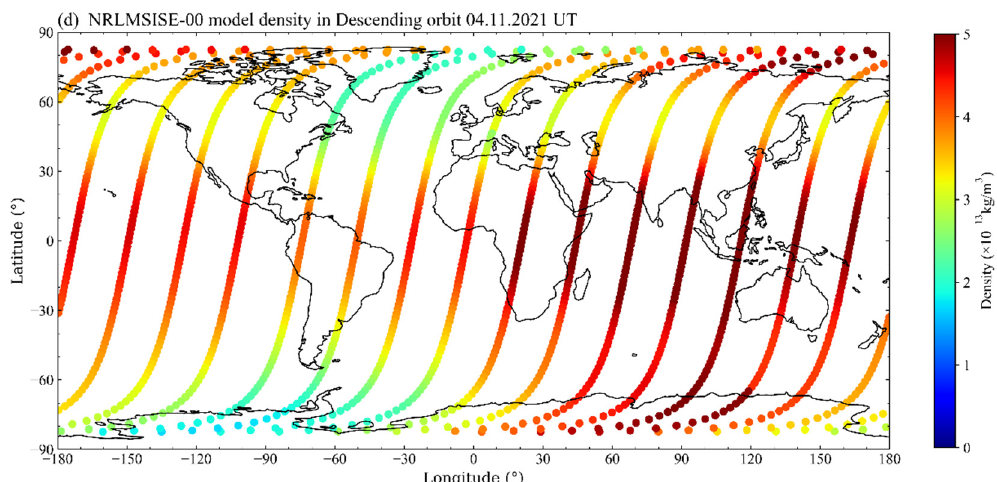
Figure 7. QQ-Satellite-derived atmospheric density in the ( a ) ascending and ( b ) descending orbits; NRLMSISE-00 model density in the ( c ) ascending orbit and ( d ) descending orbits on 4 November 2021 UTC time.